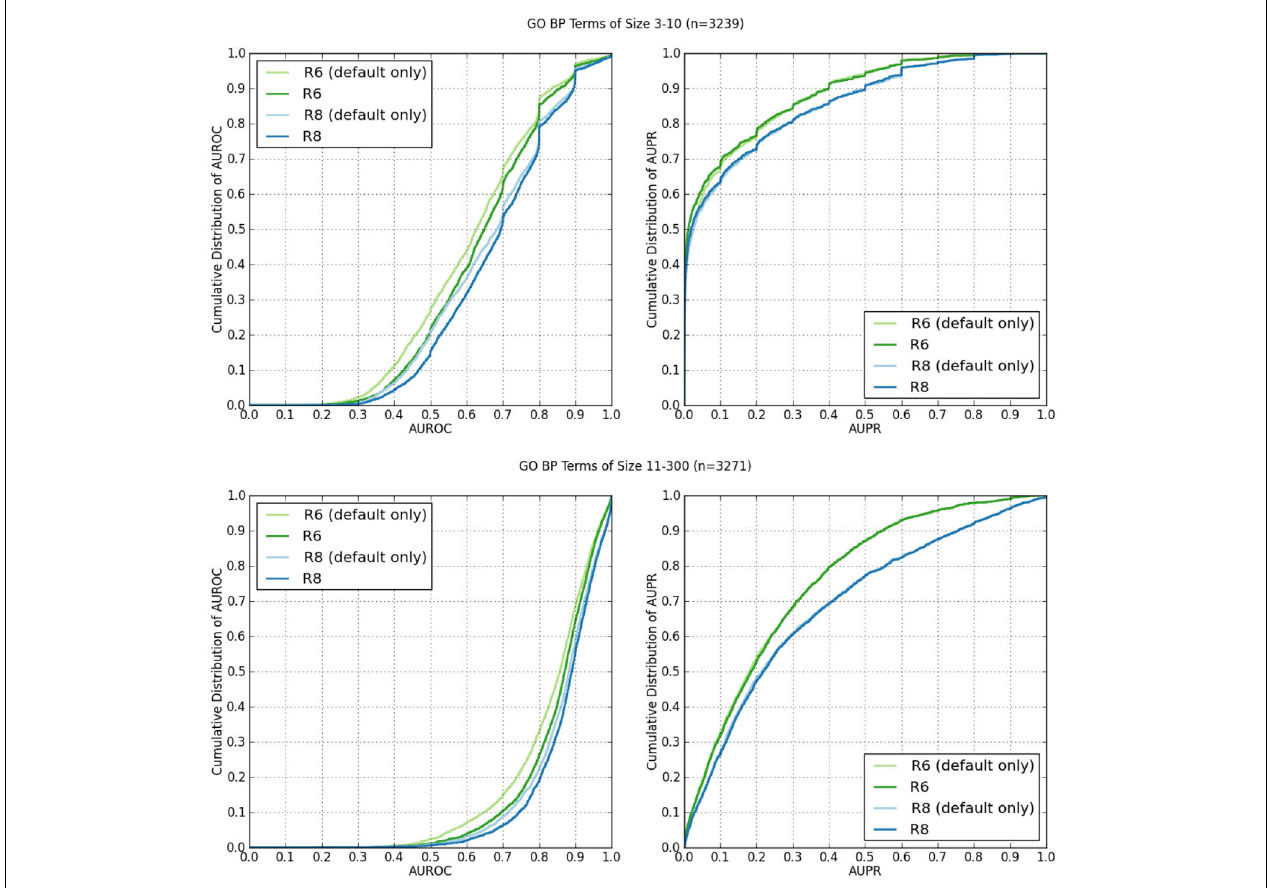
FIGURE 2 | Cumulative distributions of AUROC and AUPR of GO BP terms containing 3–10 annotations, and 11–300 from human network data from R6 and R8. The “(default)” suffix indicates only